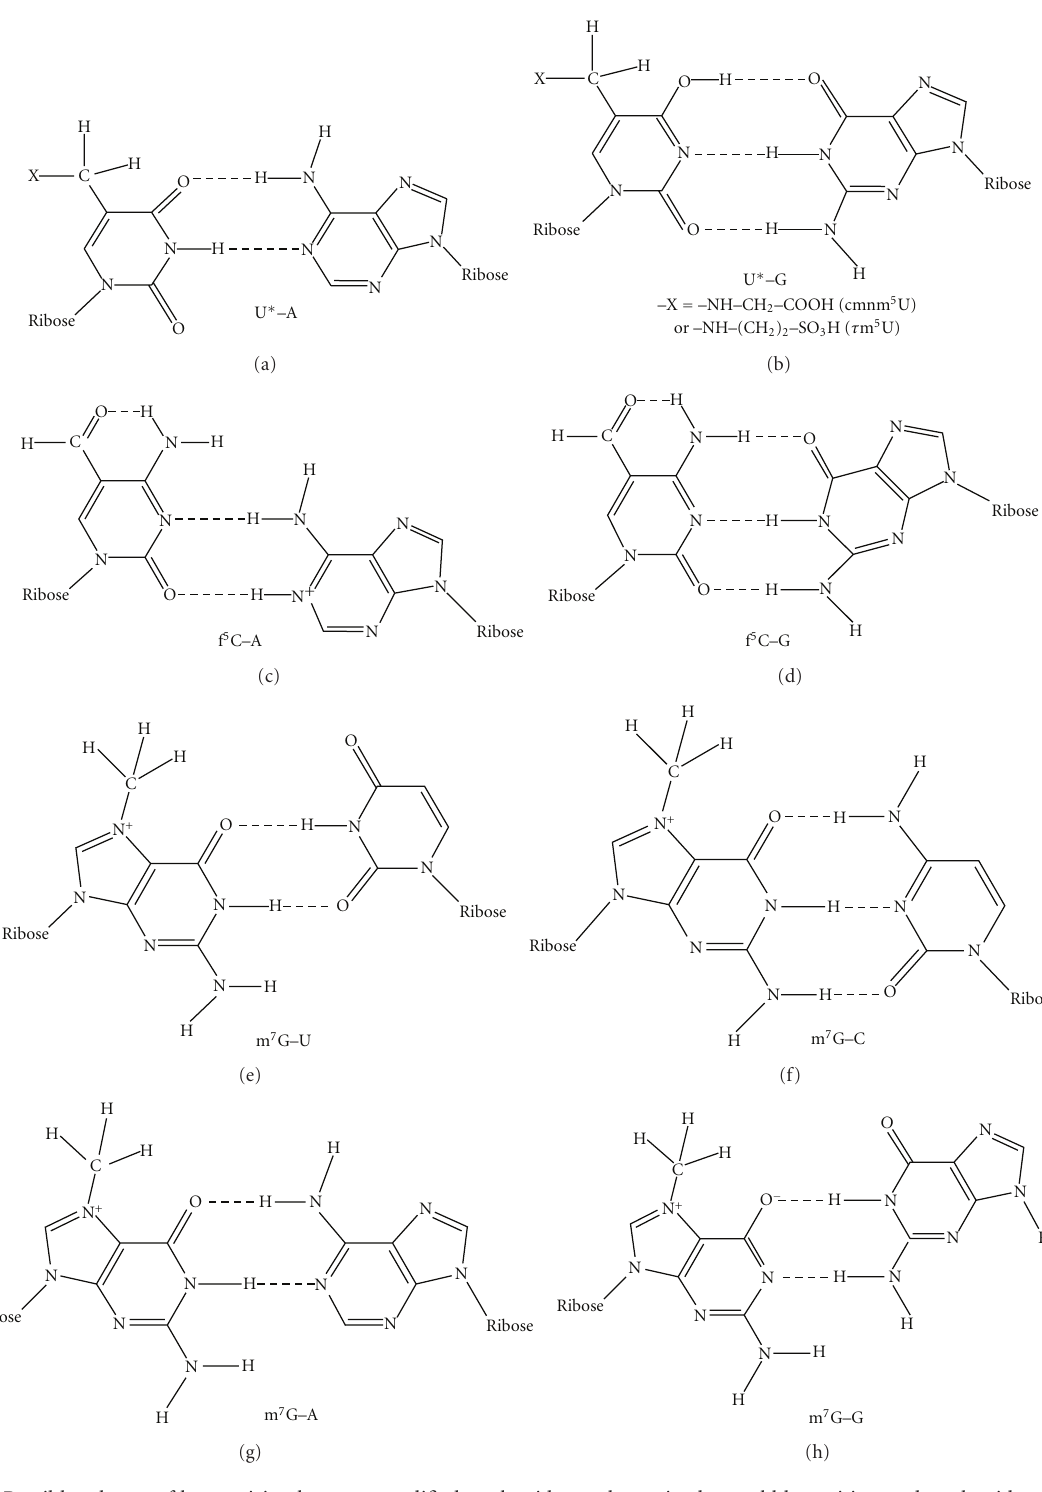
Figure 3: Possible scheme of base pairing between modified nucleosides at the anticodon wobble position and nucleosides at the codon third position in animal mitochondrial translation systems. These structures are only schematic drawing of base-pairing and do not show precise dimension of each